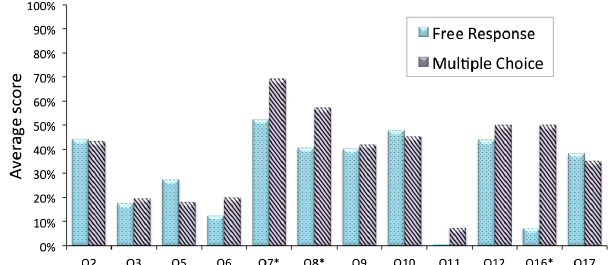
FIG. 10. Comparison of OSU students ’ average scores between FR ( N ¼ 86 , blue dotted pattern) and MC ( N ¼ 21 , purple hatched pattern) versions of the CUE. There are significant differences in scores on questions Q7 (Gauss ’ s law), Q8 (delta function), and Q16 (dipole moment, Q15 on MC), marked with an asterisk.